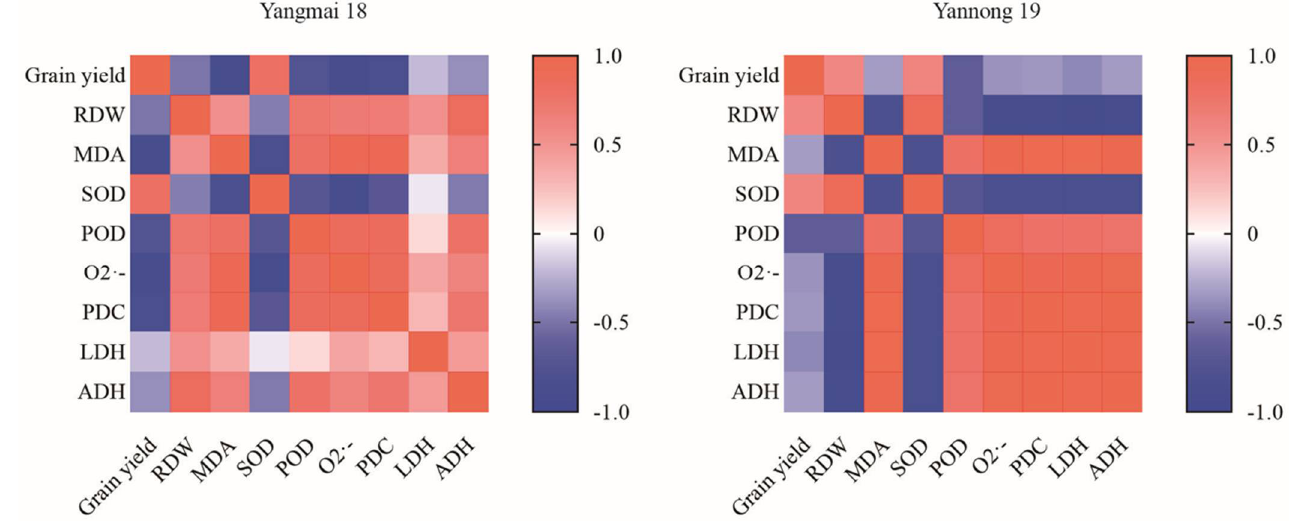
Figure 12. Correlation between wheat root measurement indexes at 7 DAA and yield under differ- ent treatments. Abbreviations: RDW, root dry weight; MDA, malondialdehyde content; SOD, su- peroxide dismutase activity; POD, peroxidase activity; O 2− , superoxide anion production rate; PDC, pyruvate decarboxylase activity; LDH, lactate dehydrogenase activity; ADH, alcohol dehydrogen- ase